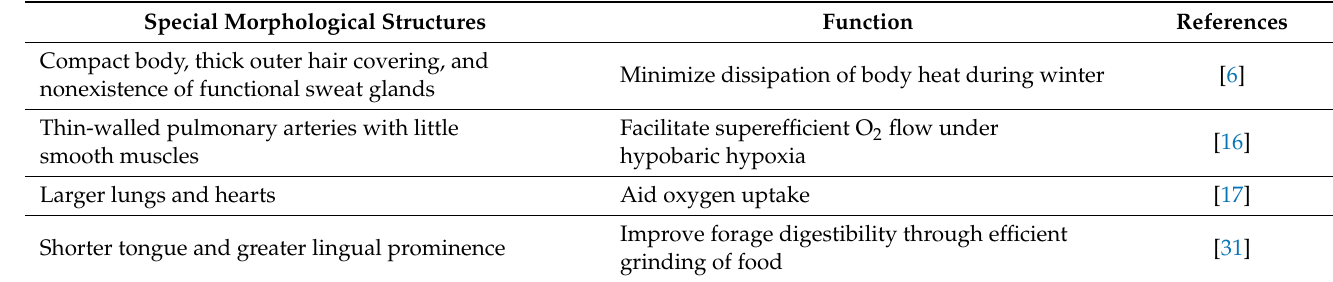
Table 1. Key morphological adaptations of yaks to high-altitude environments.